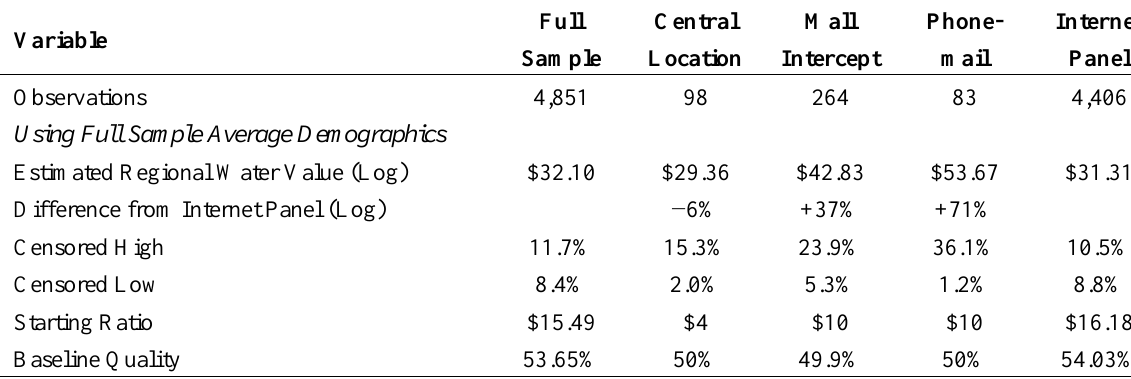
Table 4. Estimated water quality values, censoring of extreme values, and starting